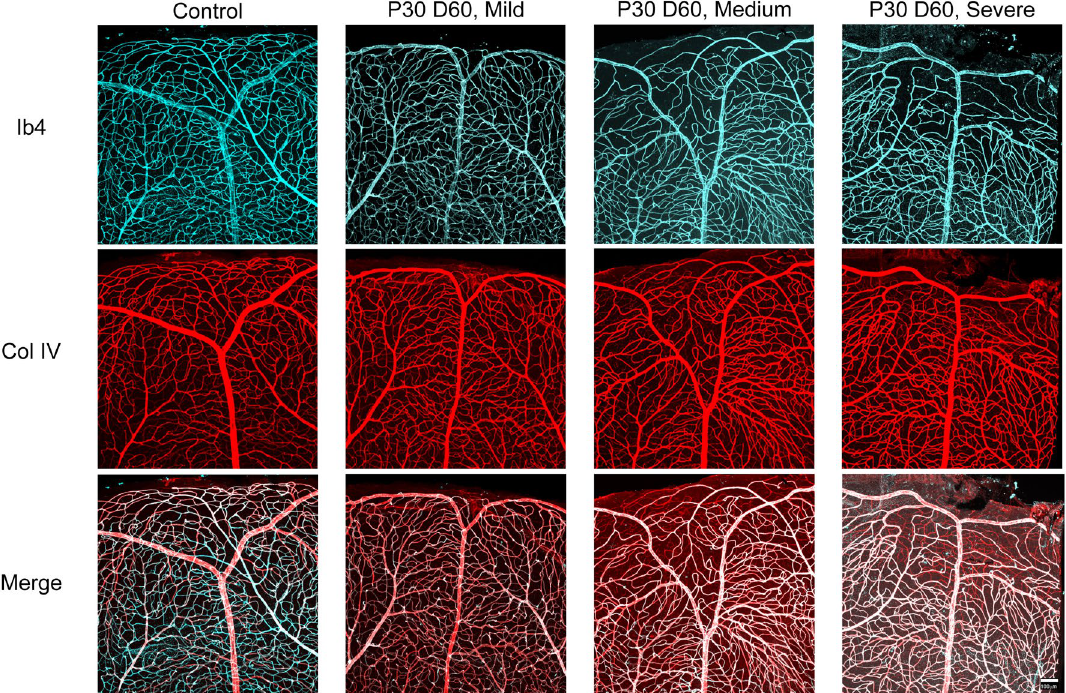
Figure 4. Vascular degeneration in juvenile mouse retina after exposure to HI. Representative images from the periphery of the superior retinas of control (right), mild, moderate, and severe HI injured (left) eyes from P30D60 mice. Retinal vasculature was labelled with Griffonia simplicifolia isolectin B4 (IB4, cyan) and anti- collagen IV antibody (Col IV, red). Vascular damage is obvious in images representing the moderate and severe HI groups. Retinas from at least four mice per group were examined. Scale bar, 50